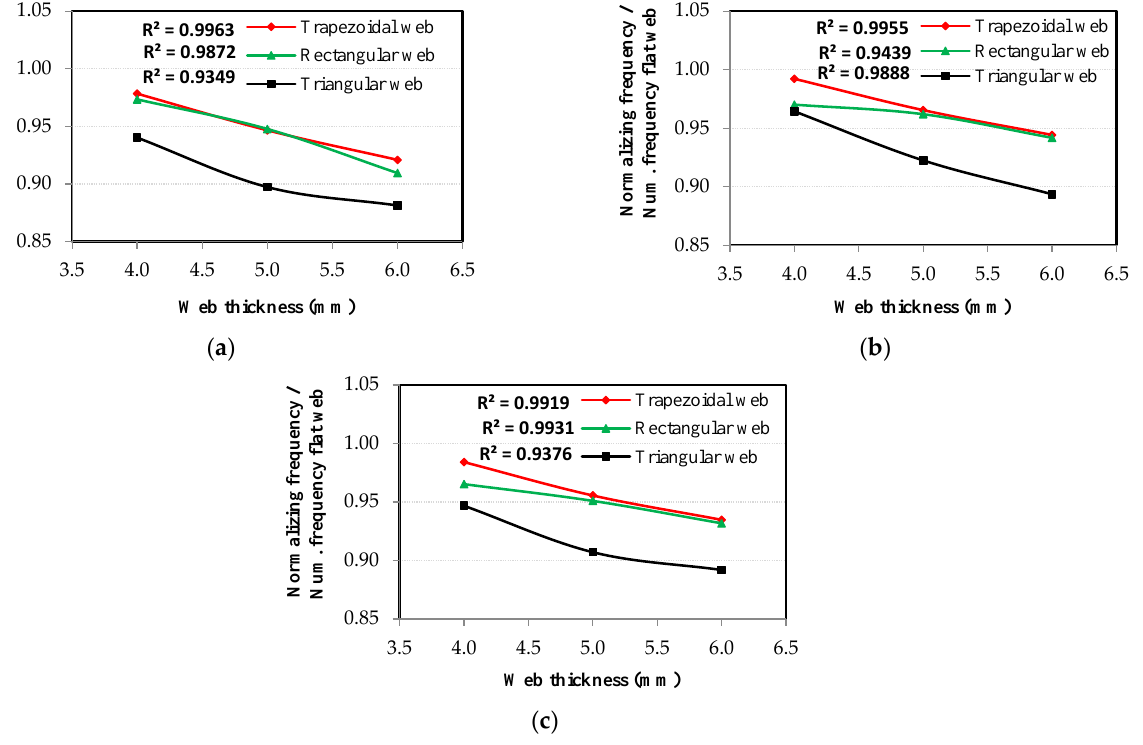
Figure 22. The relationship between normalized frequencies and corrugated web thickness: ( a ) frequency at the 1st mode shape, ( b ) frequency at the 2nd mode shape, and ( c ) frequency at the 3rd mode shape.